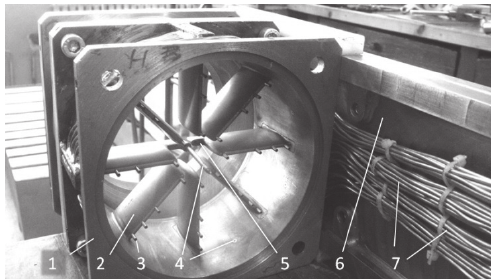
Figure 2. Physical realization and computer image of the PSM: 1 – inlet; 2 – replaceable diff user; 3 – measuring unit; 4 – throttling device; 5 – pneumatic pipelines; 6 – the base of the model (pylon)